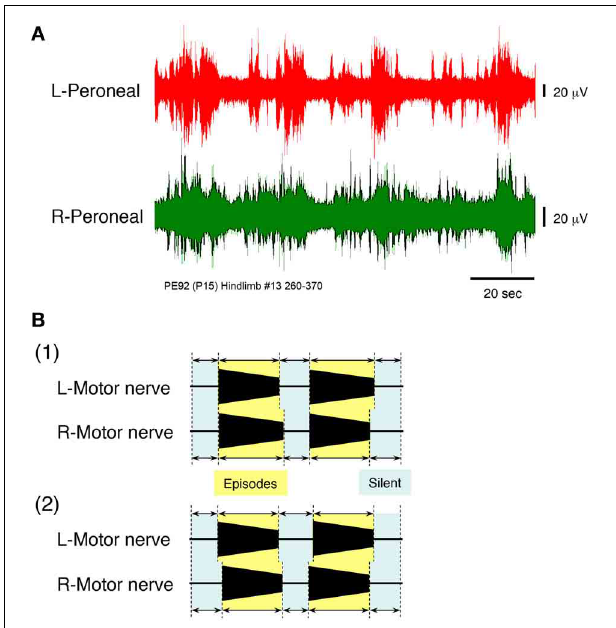
FIGURE 6 | (A) Recordings showing the instances of left and right peripheral motor nerve discharge episodes induced by administration of high concentrations of serotonin, N -methyl-D,L-aspartate, and dopamine to a hindlimb preparation made at postnatal day 15. Neuronal discharge was recorded from the left and right peroneal nerves at a flow rate of 7 × TBV/min. After administration of 160 µ M serotonin, 80 µ M N -methyl-D,L-aspartate, and 160 µ M dopamine, neuronal discharges became organized into episodes punctuated by periods of quiescence. The discharge episodes were induced simultaneously and periodically on both sides. Individual neuronal discharge episode consisted of a rhythmic and/or burst-like activity that occurred at various frequencies. The rhythmic discharge episode in the left and right peroneal nerve showed a left–right alternating pattern. The same result was obtained in all 12 hindlimb preparations. (B1) Schematic of the episodic pattern of discharge episodes, based on the discharge episode in Figures 3 , 4A , produced at a high flow rate in a decerebrate and arterially perfused preparation. (B2) Schematic of the episodic pattern of discharge episodes, based on the discharge episode in (A) , induced by the administration of drugs to the hindlimb preparation. Periods in which discharge episodes were obtained in each nerve were defined as episodic periods and those in which no discharge episode was obtained were defined as silent periods. Both episodic and silent periods were recorded for each preparation and occurred simultaneously and repeatedly on both sides. Both episodic patterns were